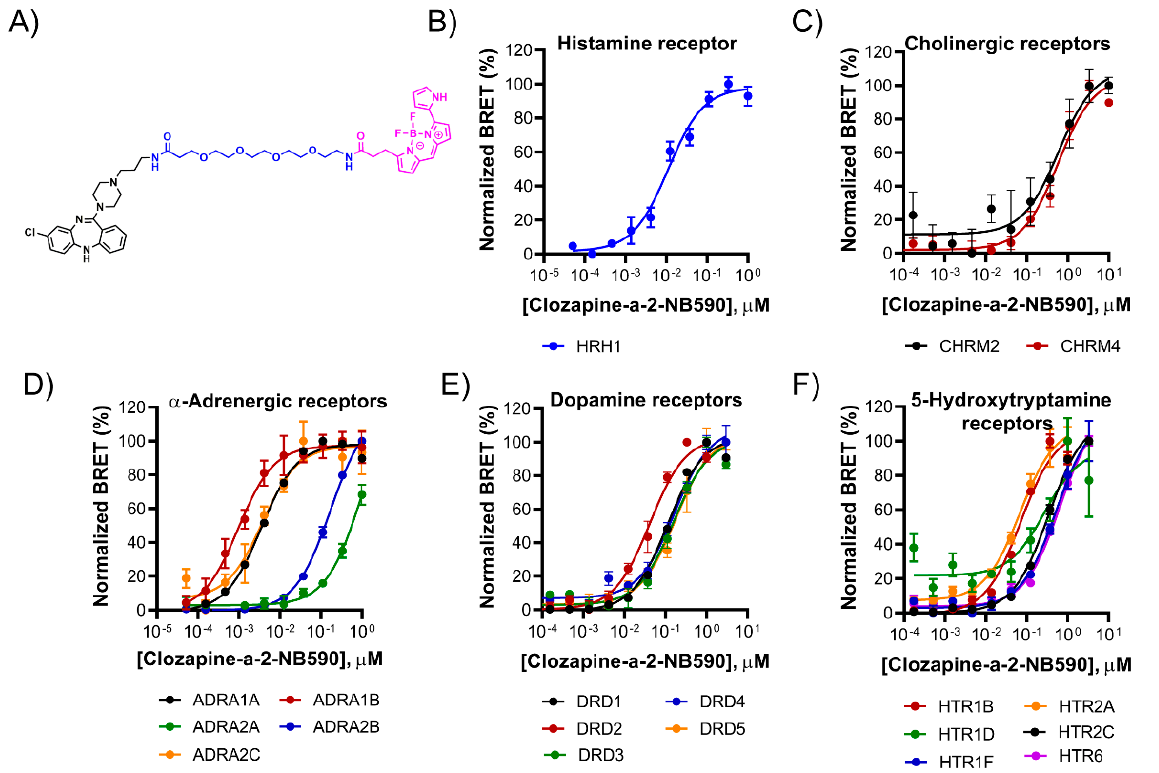
Figure 5. Saturation binding of Clozapine-a-2-NB590 to HiBiT-GPCRs from five families. ( A ) Structure of Clozapine-a-2- NB590. ( B – F ) Specific dose-dependent BRET measurements for HiBiT-GPCRs expressed in HEK293 cells. BRET values at each Clozapine-a-2-NB590 tracer concentration were background-corrected by subtracting parallel measurements taken in the presence of competing Clozapine. Data represent the mean ± S.D. of triplicates.